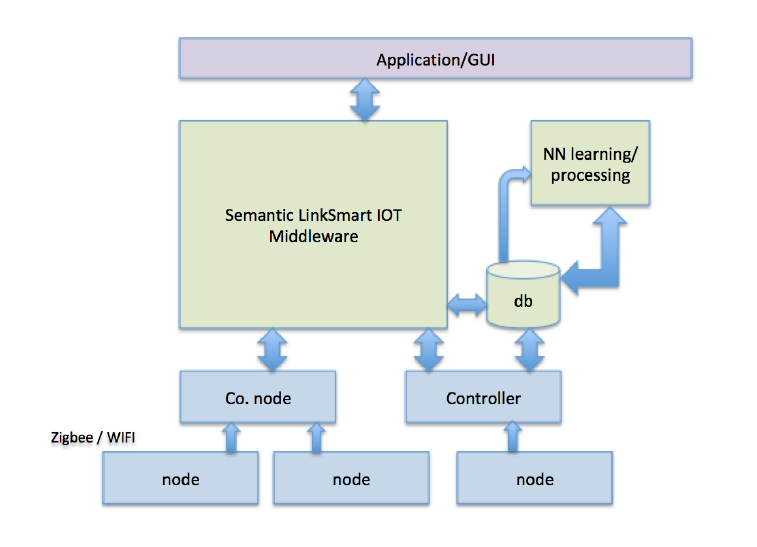
Figure 2. System